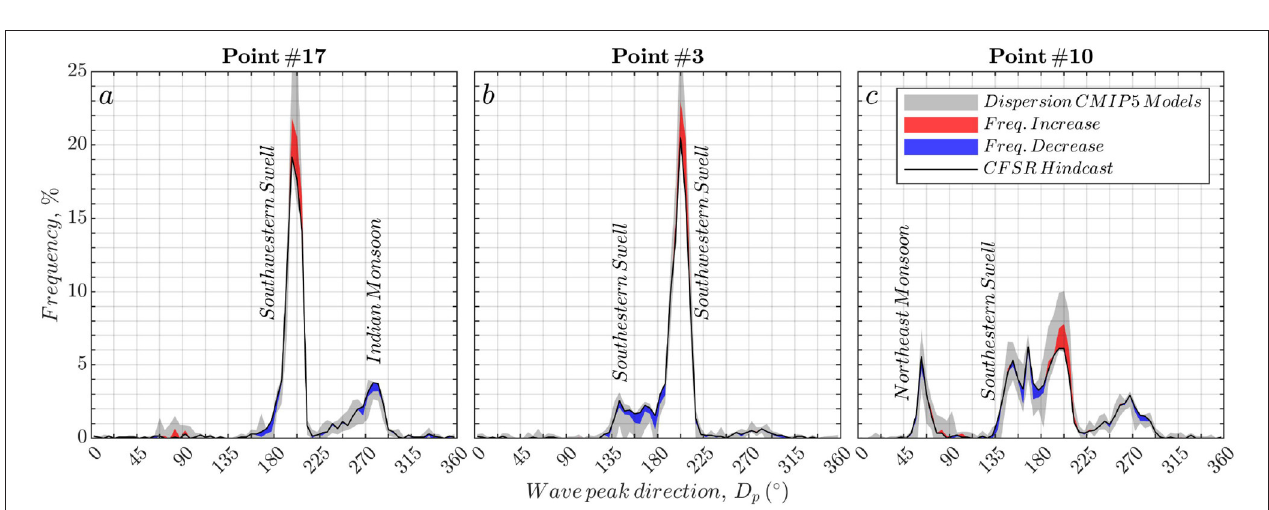
FIGURE 5 | Projected changes in wave direction by the CMIP5 models described in section 2.1 for each one of the representative points selected ( a point #17, b point #3, and c point #10). Black line represents the CFSR hindcast histogram (same as the first row in Figure 3 ); grey shadow indicates the spread of the CMIP5 models (RCP8.5 - Historical); red (blue) shadows show where the models agree to project a frequency increase (decrease) of a given direction.